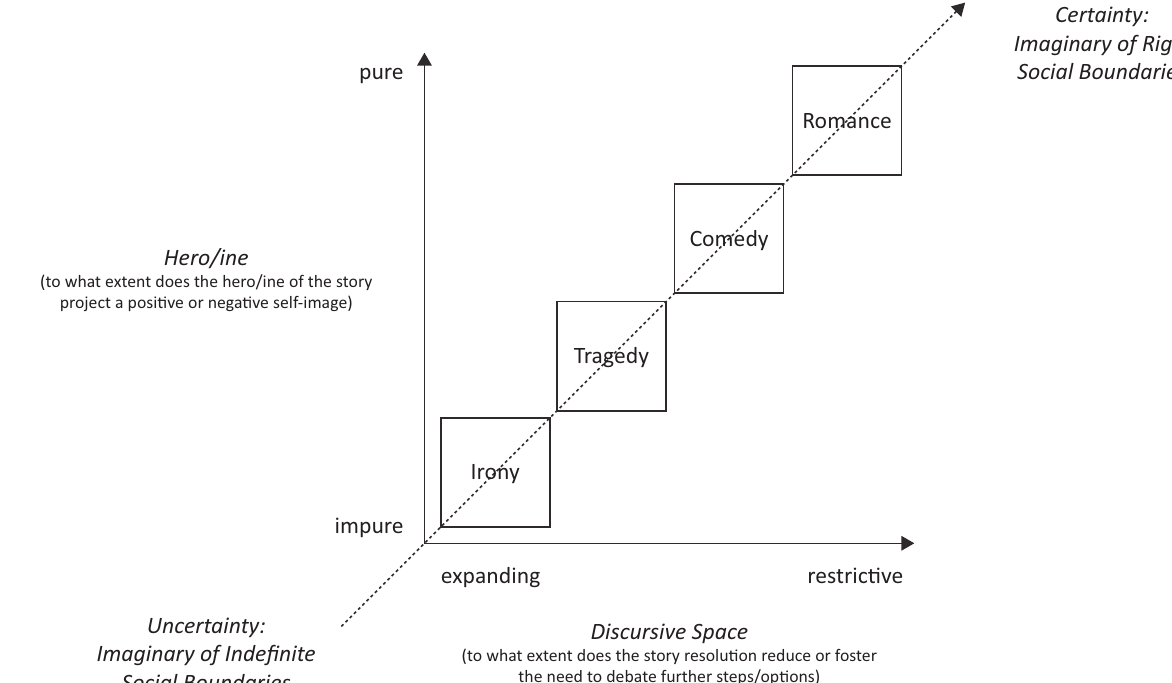
Figure 2. Schematic representation of the link between narrative genres and social boundaries (a modified version of the model proposed by Forchtner et al., 2018, p.